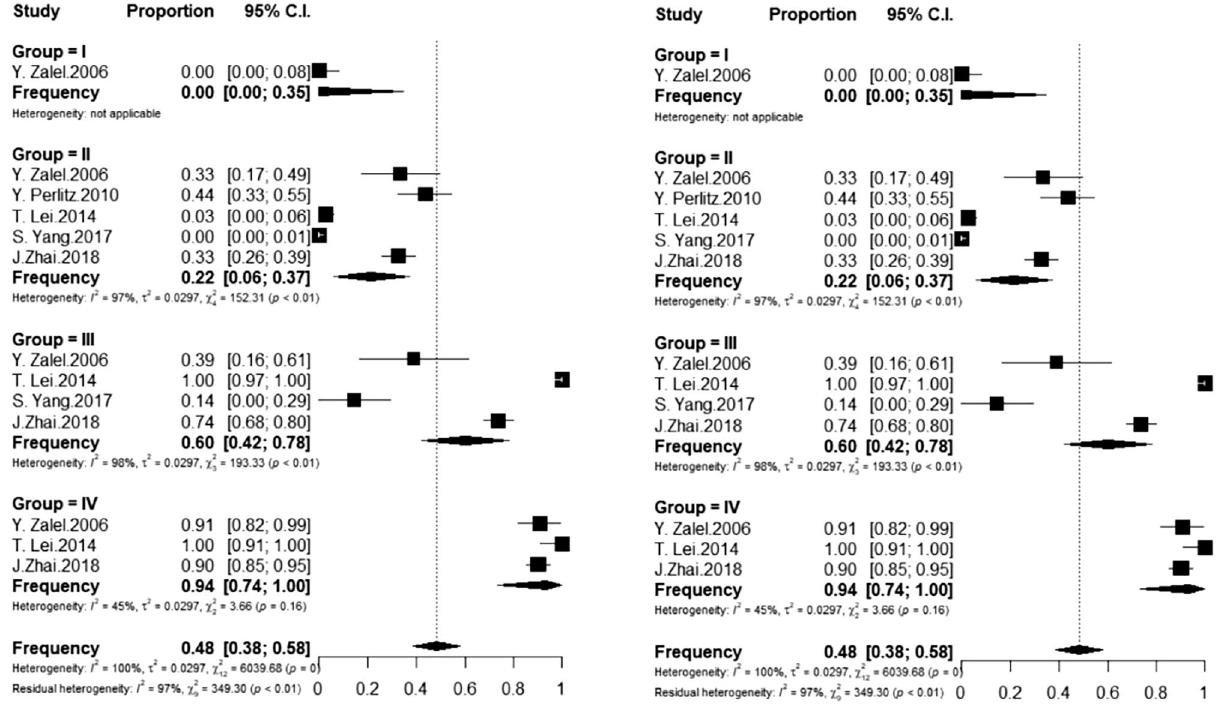
Figure 6. Frequency of foetuses evaluated by ultrasound with CM at L2 or above distributed by gestational age group. Group I (13–18 weeks); II (19–25 weeks); III (26–32 weeks); IV (33 weeks to the probable date of